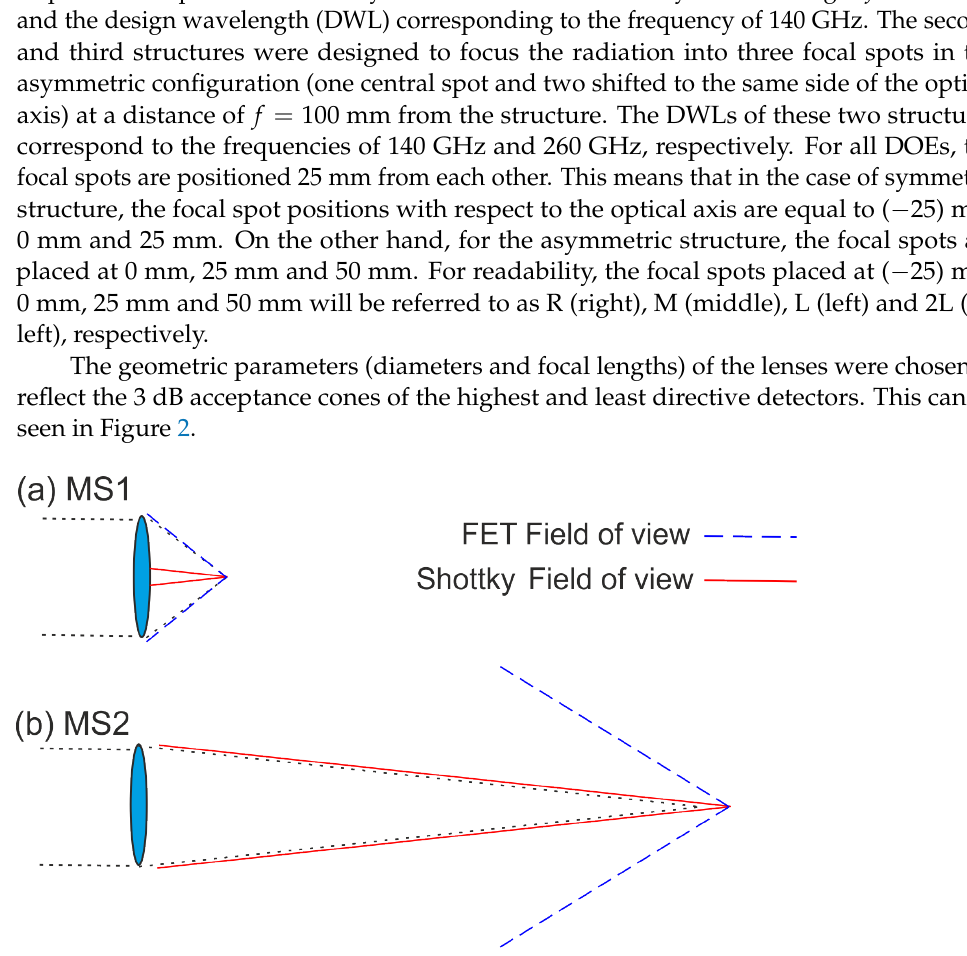
Figure 2. Simplified diagram presenting the detector field of view in relation to measured structures (MS)—( a ) MS1—DOE with f = 100 mm and ( b ) MS2—DOE with f = 700